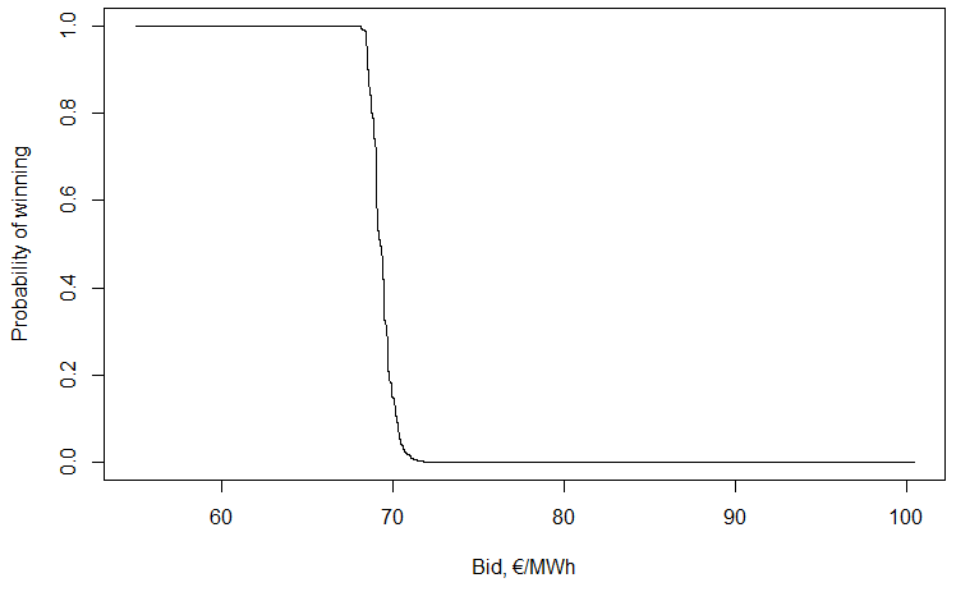
Figure A7. Probability of winning in case of different bids, assuming F 3 bid distribution, source: own figure.